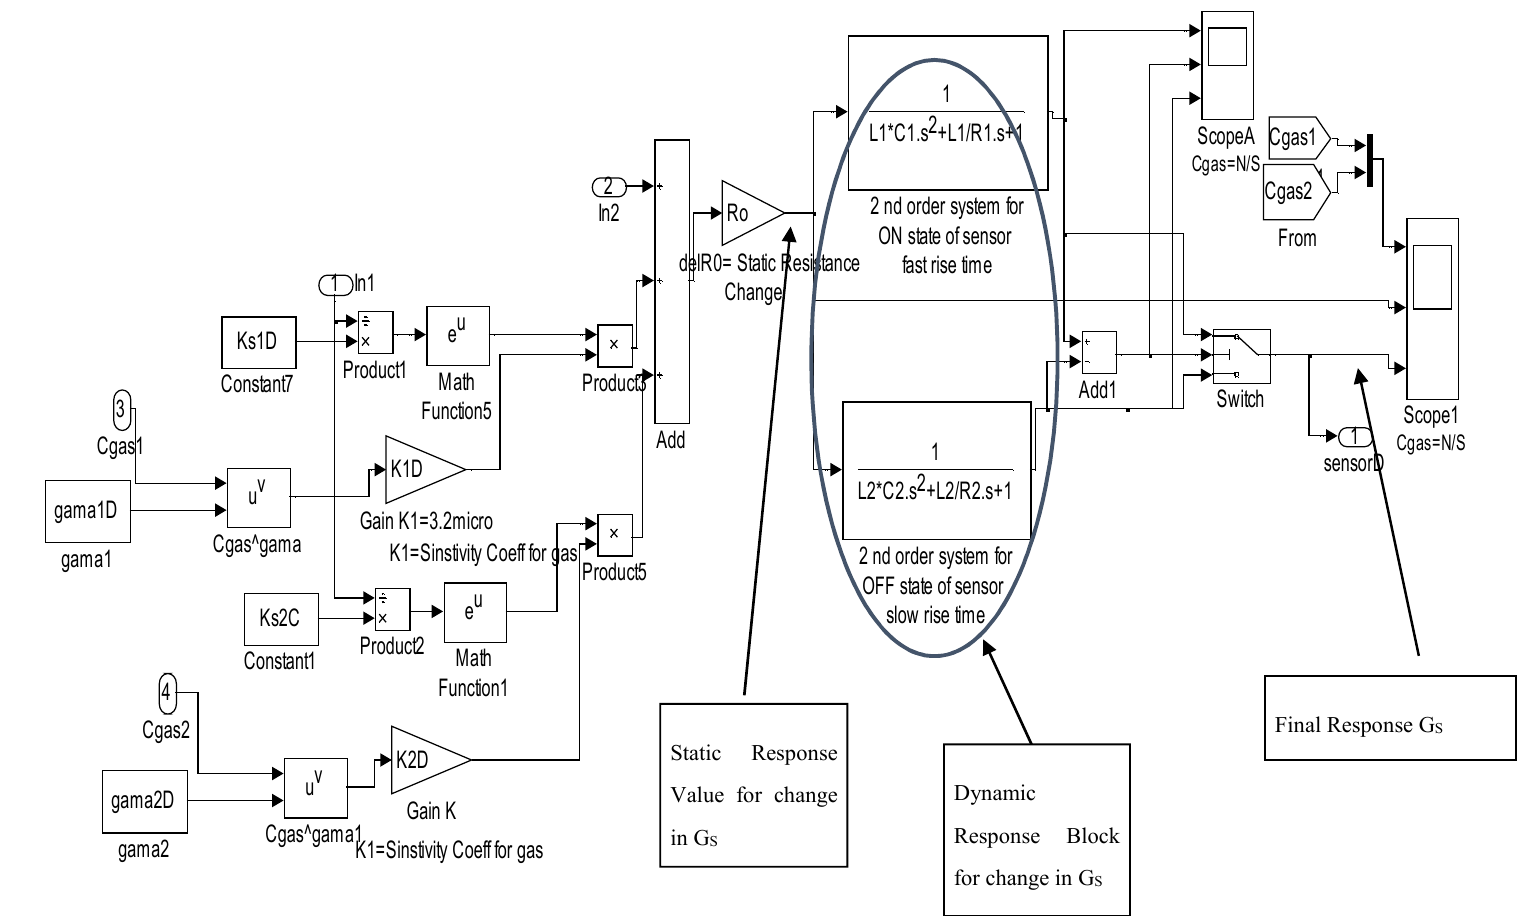
Figure 2. Simulink model of classifying a mixture of gases for each sensor .